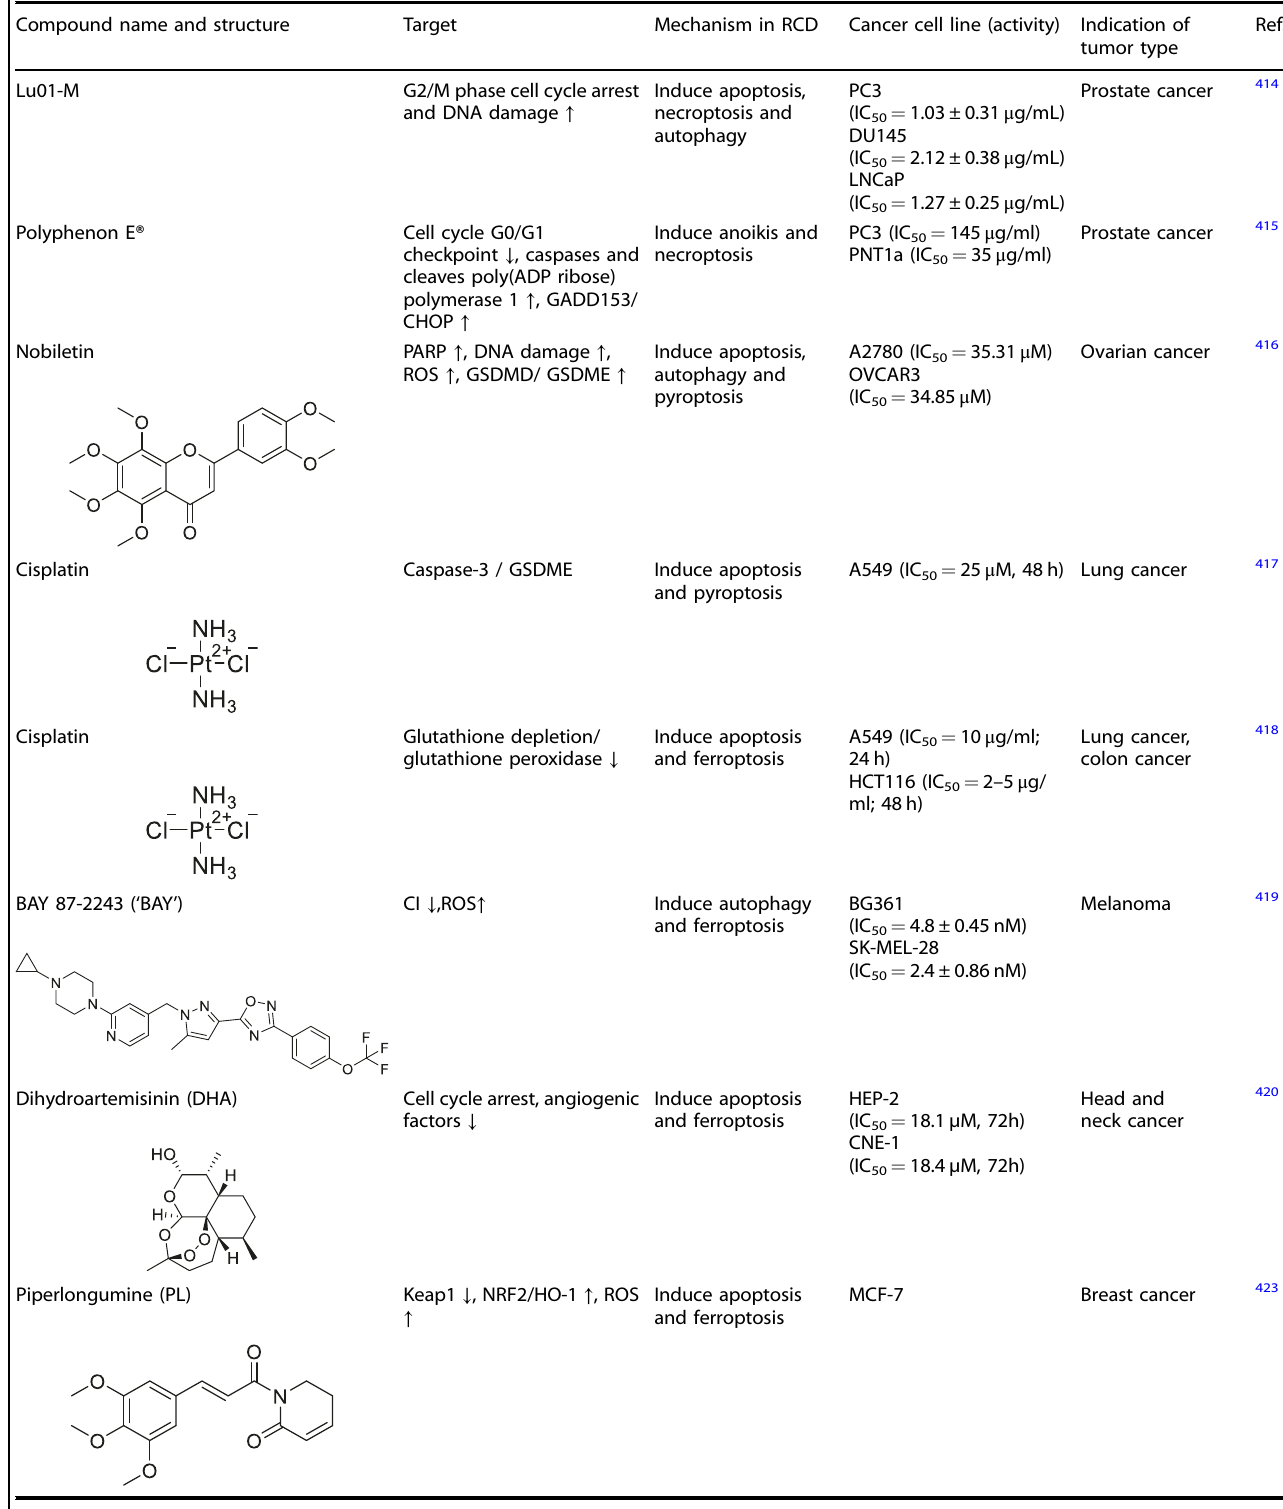
Table 14. Cancer treatment through multiple RCD signaling pathways Compound name and